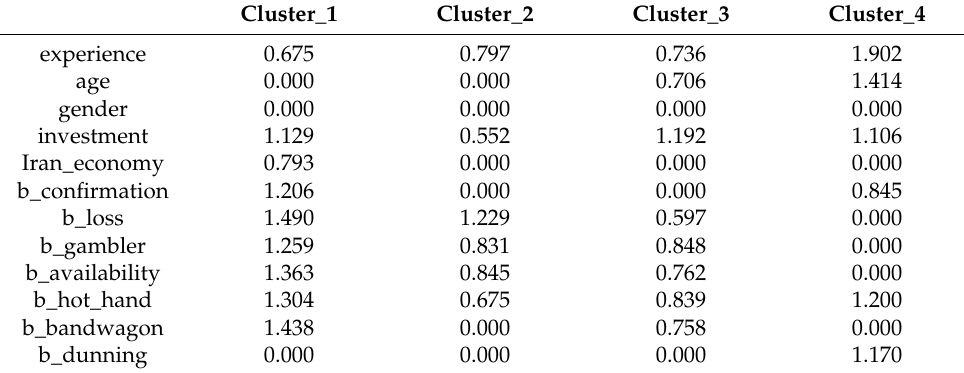
Table 6. Predominant investors’